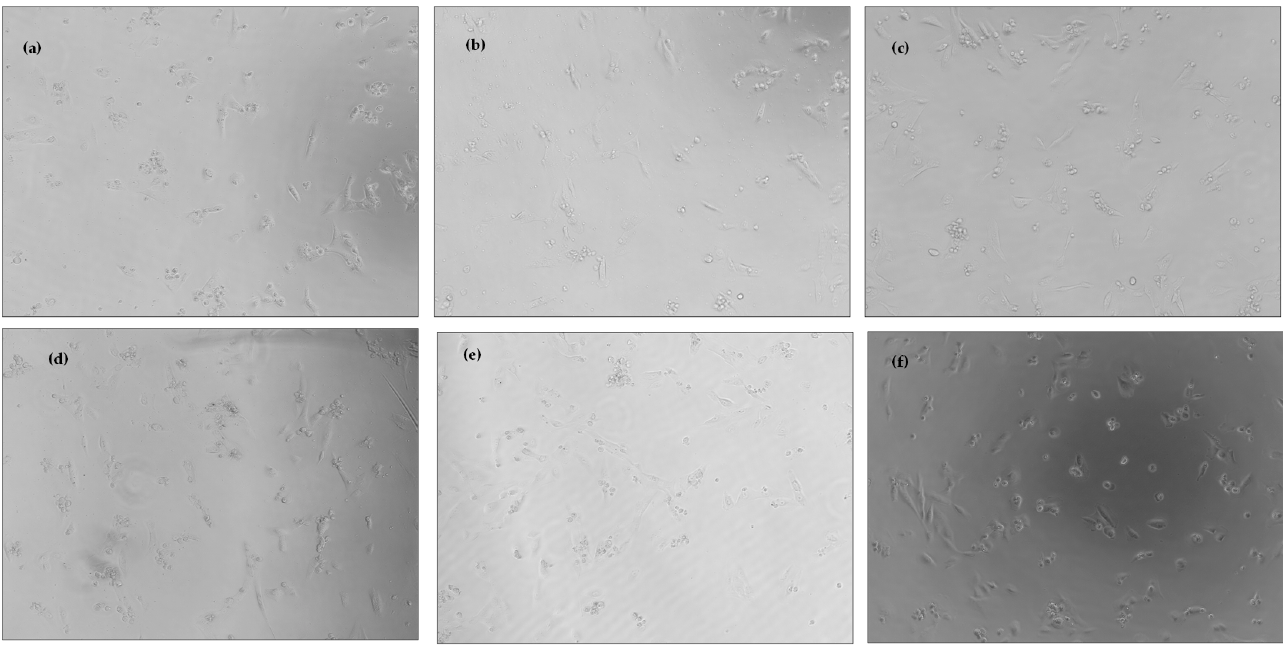
Figure 5. Viability of HREP cells against CysA-loaded transferosomes and blank transferosomes.